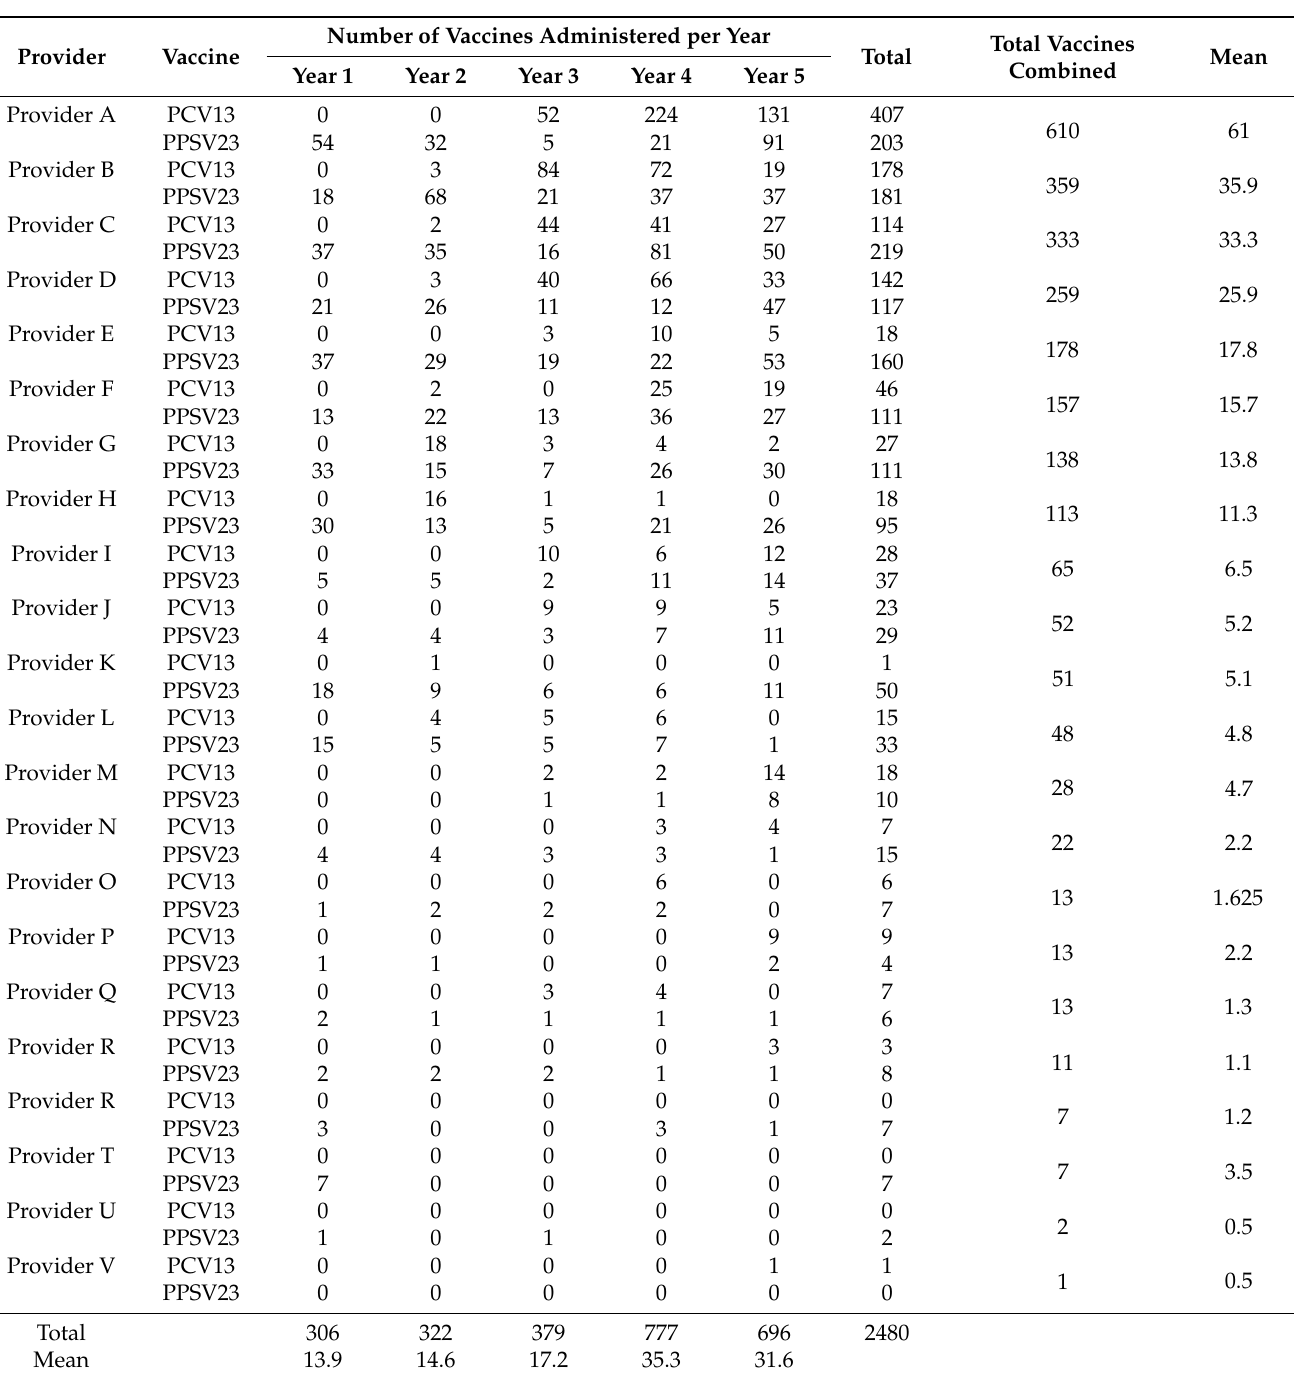
Table 2. Number of vaccinations administered organized by